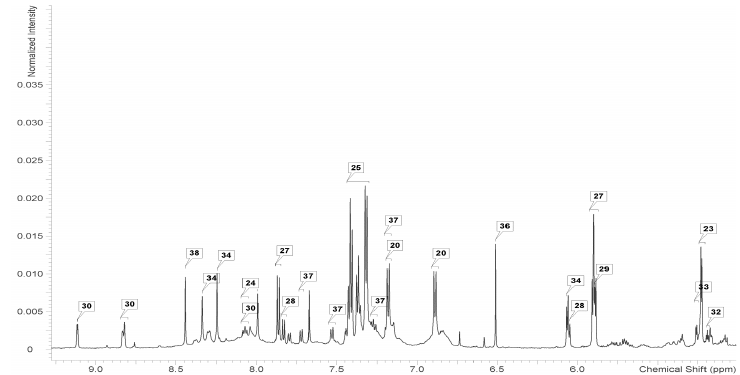
Figure A1. The figure of NMR.